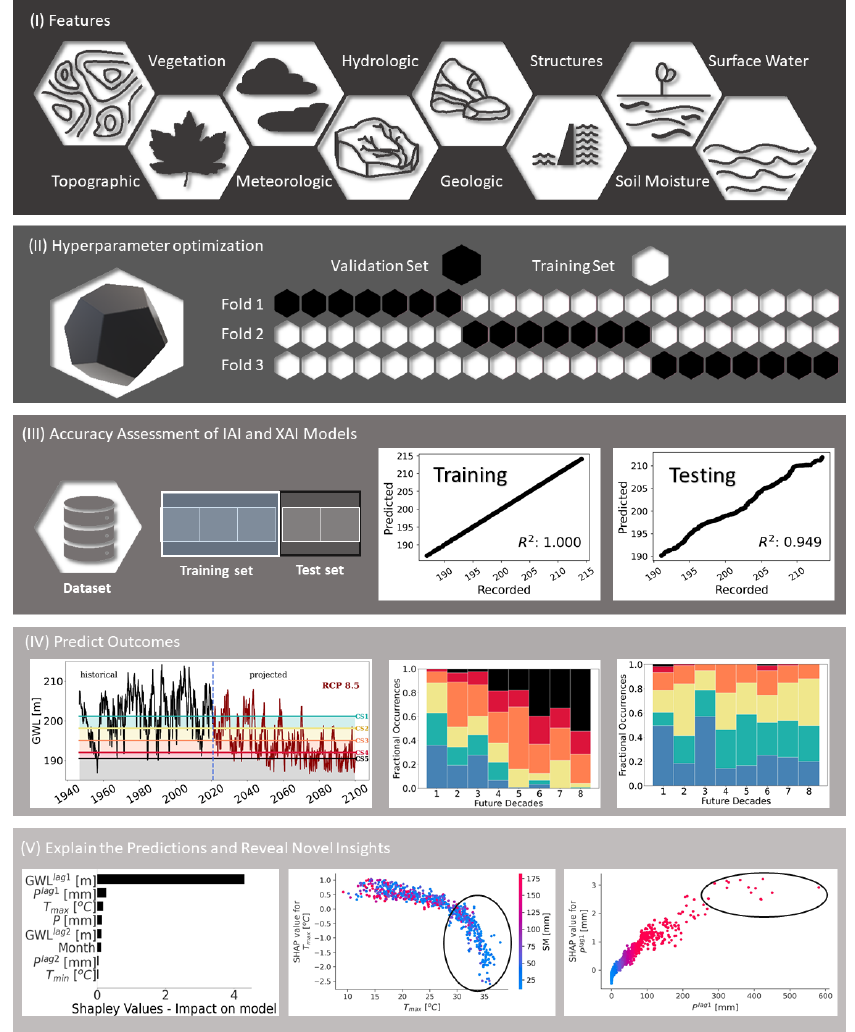
Figure 2. A generalized framework of an XAI model. Basic steps include: ( I ) collection and curation of hydroclimatic data sets to be used to train the AI model and test its prediction performance; ( II ) grid search hyperparameter optimization using multi-fold cross validations to find the best set of parameters for AI model runs, ( III ) AI model training and determination of its prediction accuracy on test data based on statistical measures; ( IV ) prediction/projection of hydroclimatic variables using the validated AI model; and ( V ) determination of the rank of the most influential predictors in predicting target variables based on global SHAP analyses ( left panel), and determination of the inflection point of the predictors (where the SHAP values on the y-axis change signs), based on the local SHAP analysis, above or below which the value of the predictand would increase or decrease ( right panel). The predictive AI model is transitioned into the IAI and XAI models in ( V